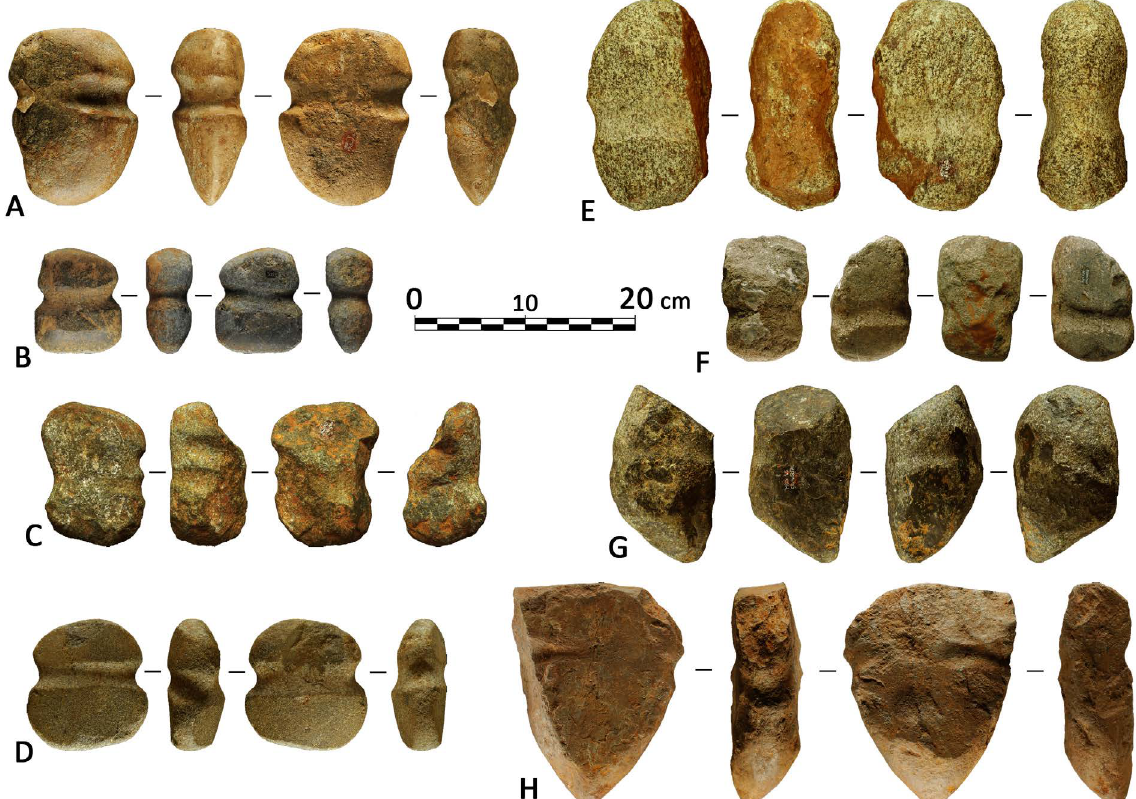
Figure 3. Some of the mining tools found within Grotta della Monaca: A-B. hammer-axes; C-F. hammers; G-H.